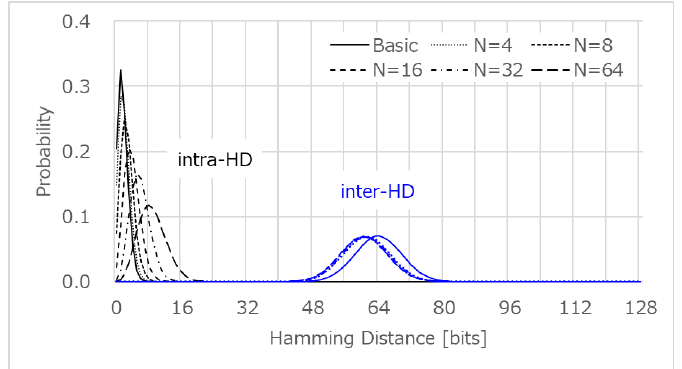
Figure 8. Measurement results of intra-HD and inter-HD.